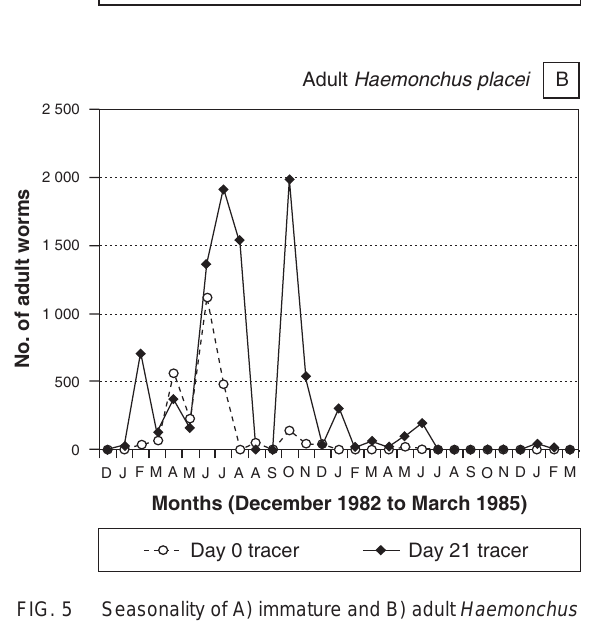
FIG. 5 Seasonality of A) immature and B) adult Haemonchus placei in tracer calves on the farm "Glen Dye",